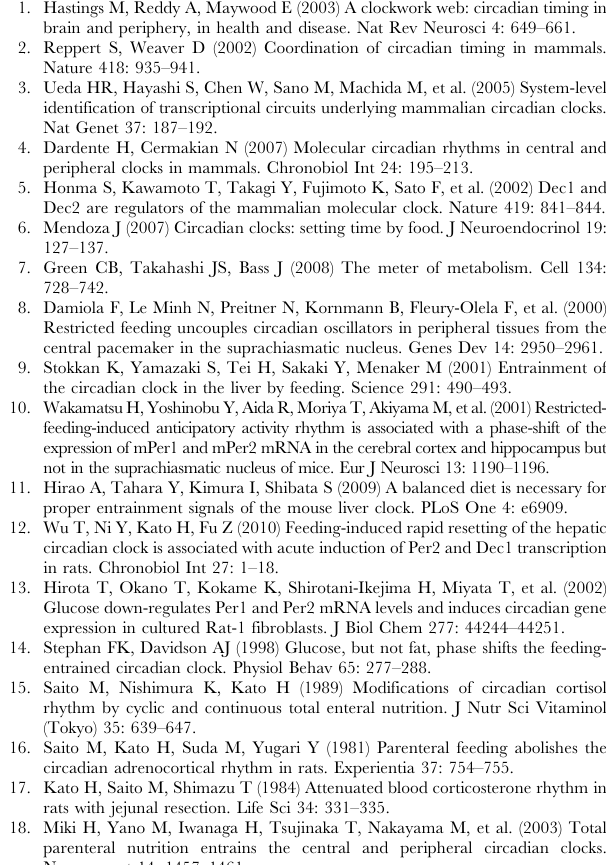
Figure S2 Dbp and Bmal1 expression in liver 1 h after resumed feeding. Expression of mRNA for Dbp in liver under